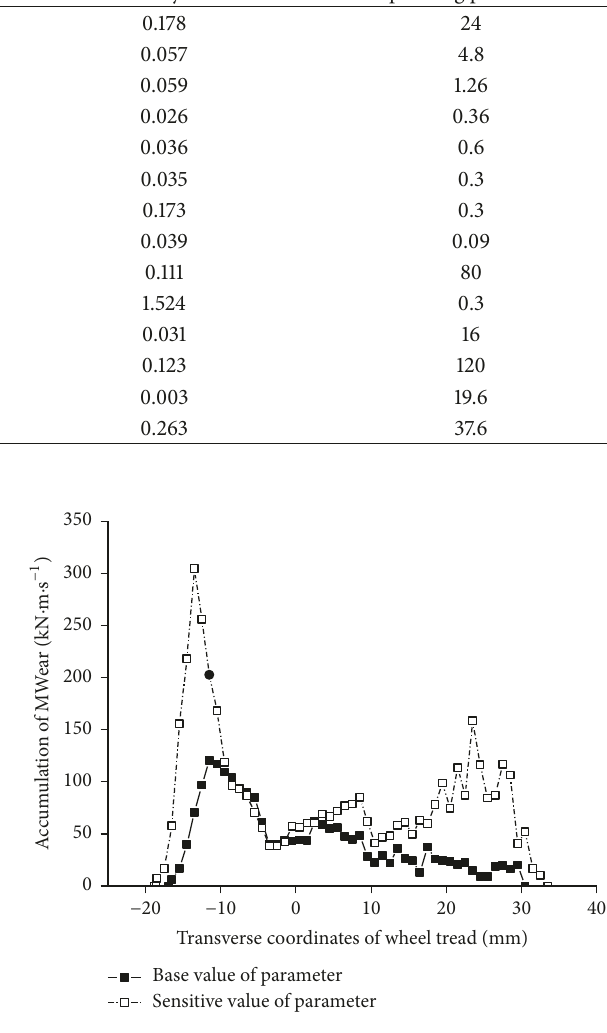
motion damper on the cumulative wear power dissipation of the